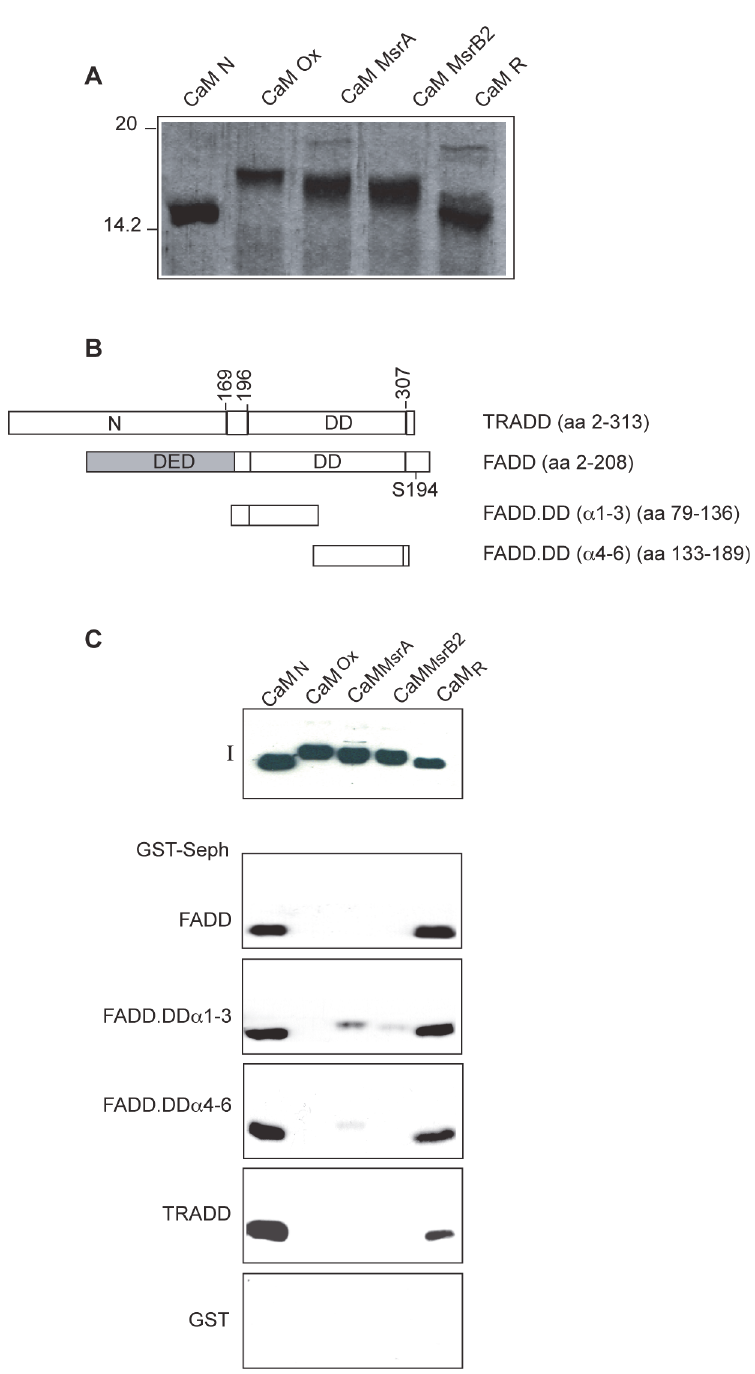
Figure 3. Methiones oxidation impairs CaM interaction with FADD and TRADD. A : CaM oxidation analysis. Coomassie blue stained 15% SDS-PAGE loaded with the indicated Xenopus laevis His-CaM proteins. B . Schematic representation of GST-FADD and GST-TRADD proteins used in pull-down assays. The DED, DD and the S194 phosphorylation site of human FADD are indicated. C : GST pull-down assays. The indicated GST proteins bound to gluathione-sepharose beads were incubated with recombinant His- CaM proteins, as indicated; 50% of the eluted proteins were subjected to SDS-PAGE (12%) and western blot analysis. I indicates the input of the CaM proteins used in binding assays. The data shown are representative of at least three independent experiments.